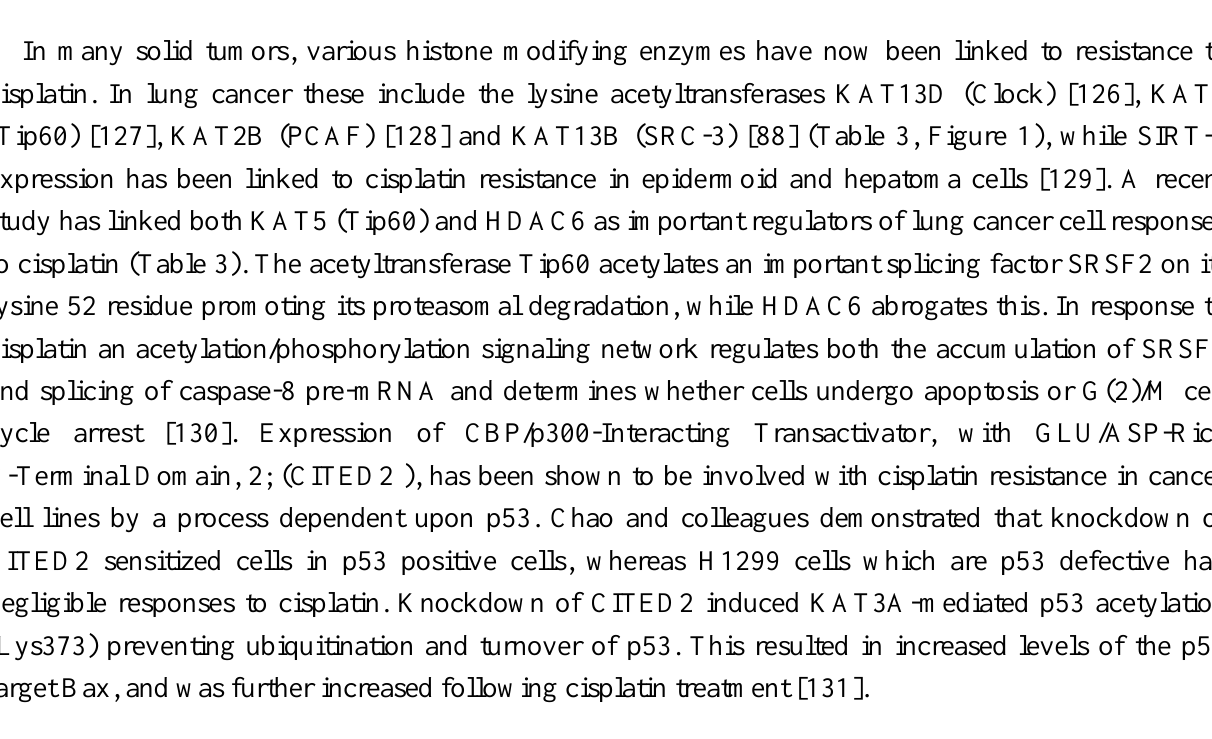
Table 3. Epigenetic Modifiers associated with cisplatin resistance in